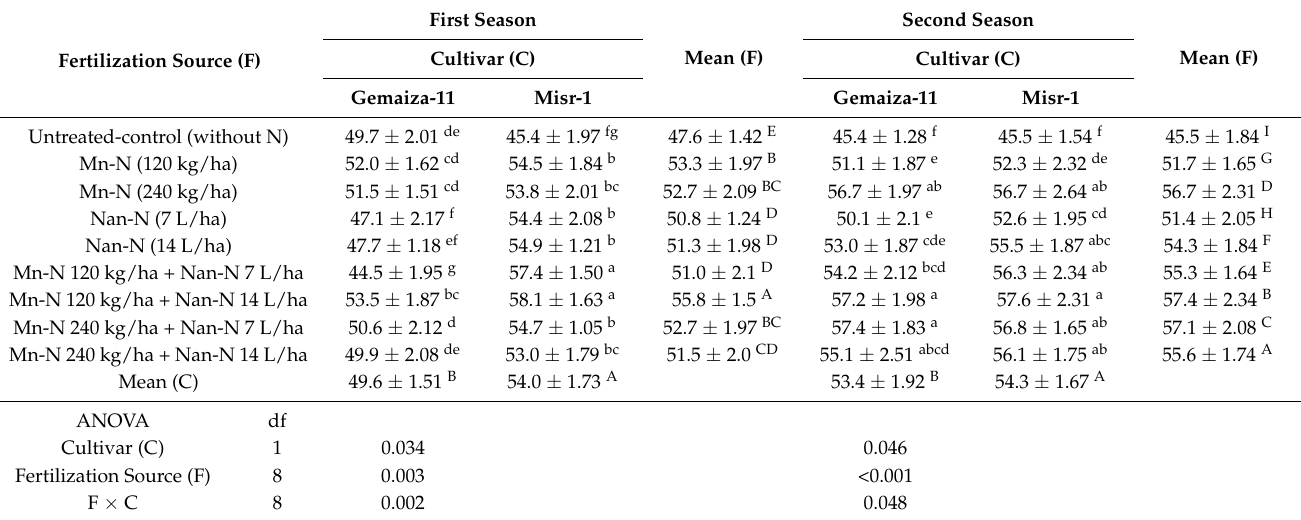
Table 7. Impact of nano- and mineral nitrogen fertilizers on the 1000-grain weight (g) of two wheat cultivars during the 2019/2020 and 2020/2021 seasons.